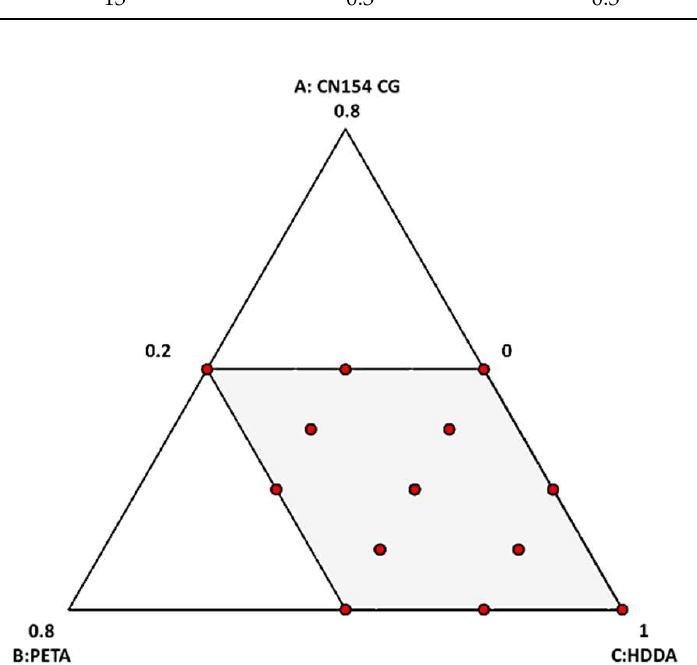
Figure 3. Distribution of experiment design points in the investigated range of parameters. A: CN154CG, B: PETA, and C: HDDA .